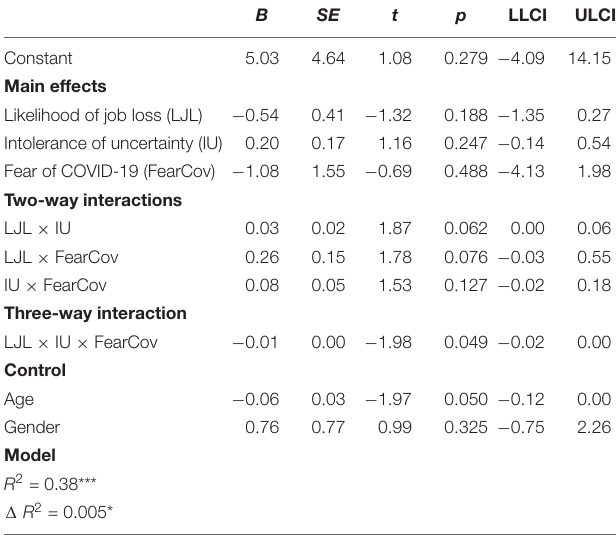
and Fear of COVID-19 as moderators, and Distress as criterion variable. Results revealed somewhat different structure (presented in Table 7